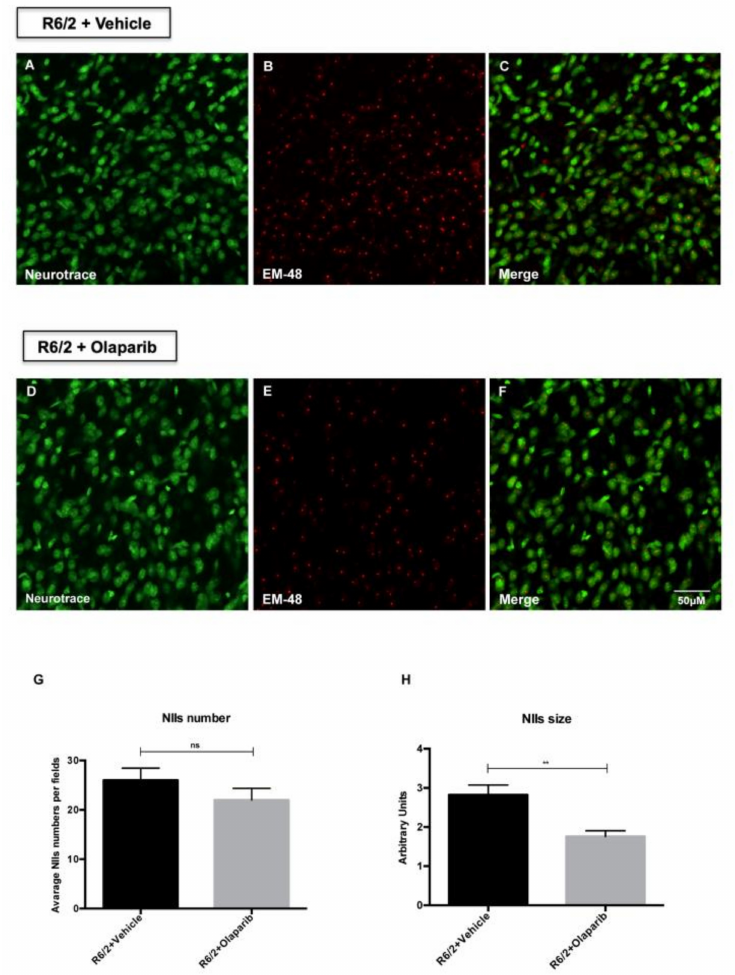
Figure 2. Primary outcome measures: Olaparib reduces neuronal intranuclear inclusions (NIIs) size in R6 / 2 mice. ( A – F ) Representative images of NIIs counterstained with green fluorescent Nissl in vehicle or Olaparib-treated R6 / 2 mice. ( G , H ) Two-way ANOVA analysis performed on data obtained by vehicle and Olaparib-treated R6 / 2 mice revealed a statistically significant e ff ect of treatment on NIIs size. Unpaired t test with Welch (cid:48) s correction performed on comparison analysis revealed a statistically significant decrease of NIIs size in the R6 / 2 mice group treated with Olaparib compared to that of vehicle-treated R6 / 2 mice ( p <